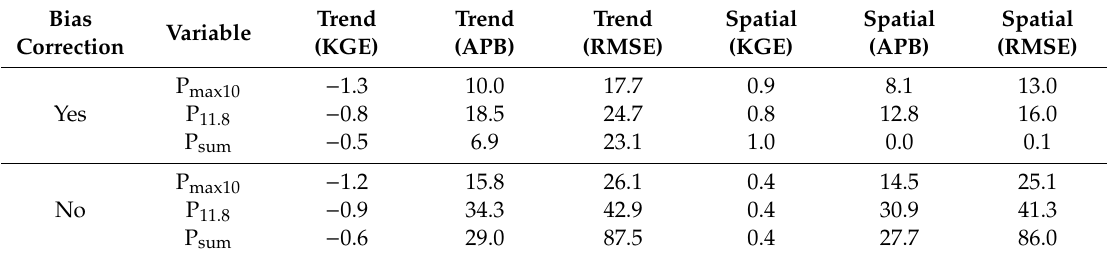
Table A3. Average e ff ect of bias correction on the performance of climate